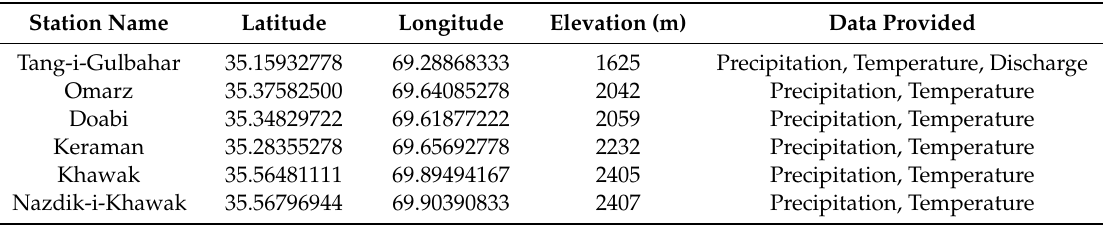
Table 1. Hydro-meteorological station information used in this